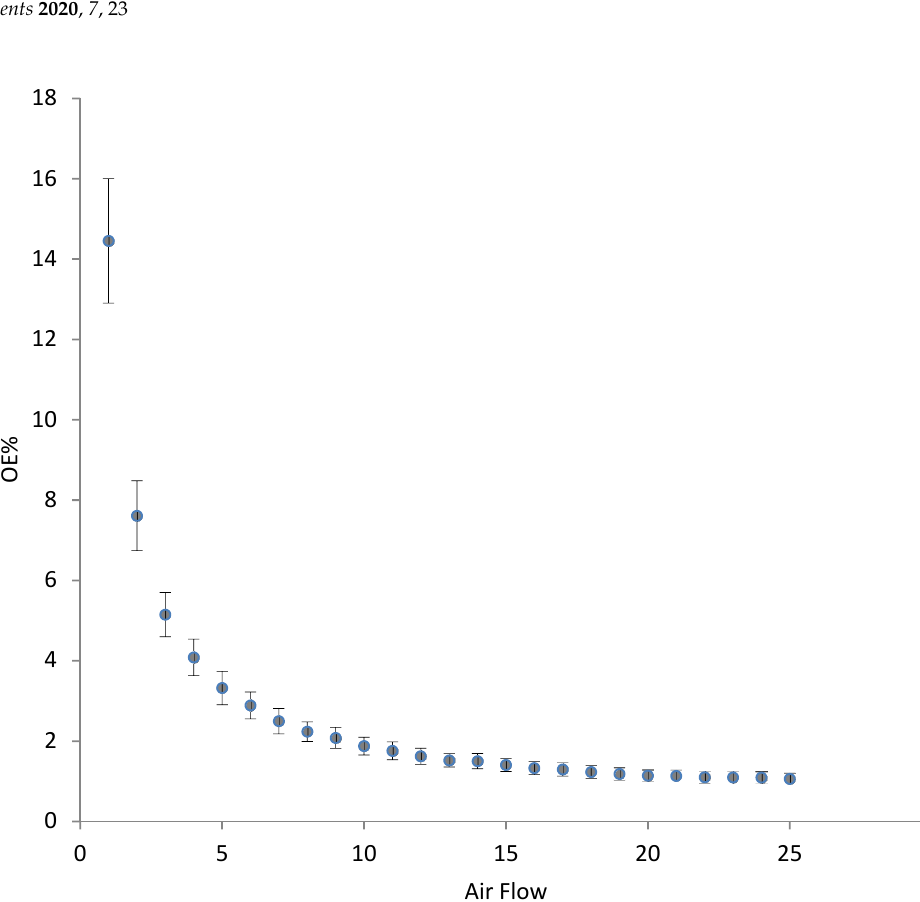
Figure 9. The oxygenation e ffi ciency OE% in the ordinate vs. air flow (L min − 1 ) in the abscissa.